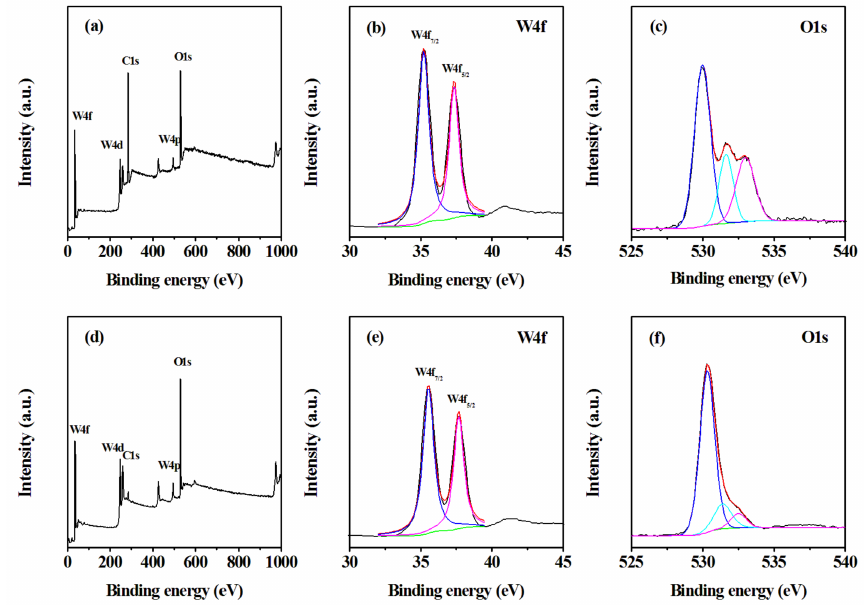
Figure 5. XPS spectra of the formed WO 3 with different shapes. ( a – c ) WO 3 nanobundles, ( d – f ) WO 3 nanorods.